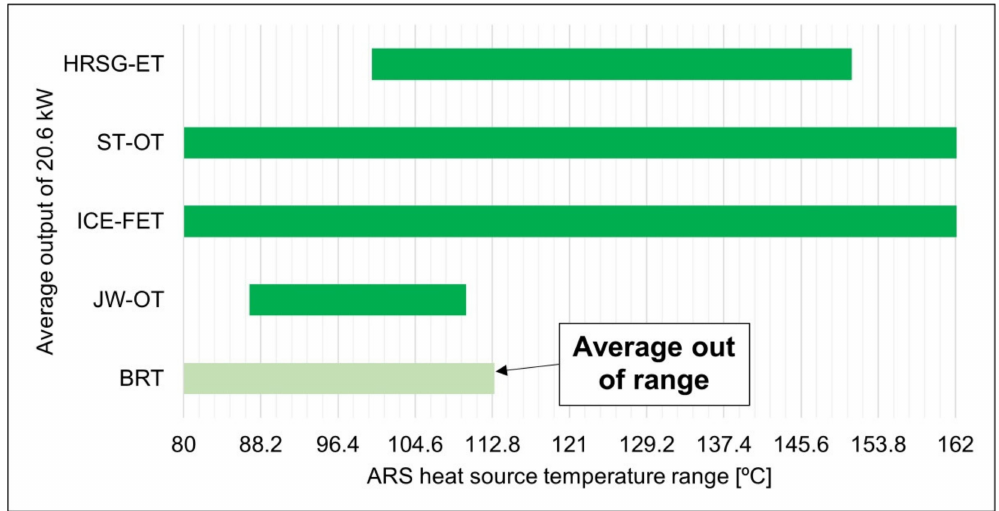
Figure 7. Potential waste heat recovery technologies suitable for feeding Absorption Refrigeration